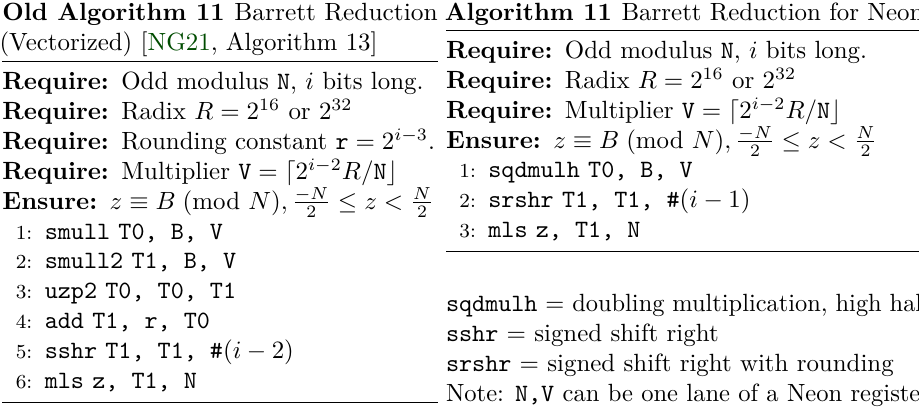
Algorithm 11 Barrett Reduction for